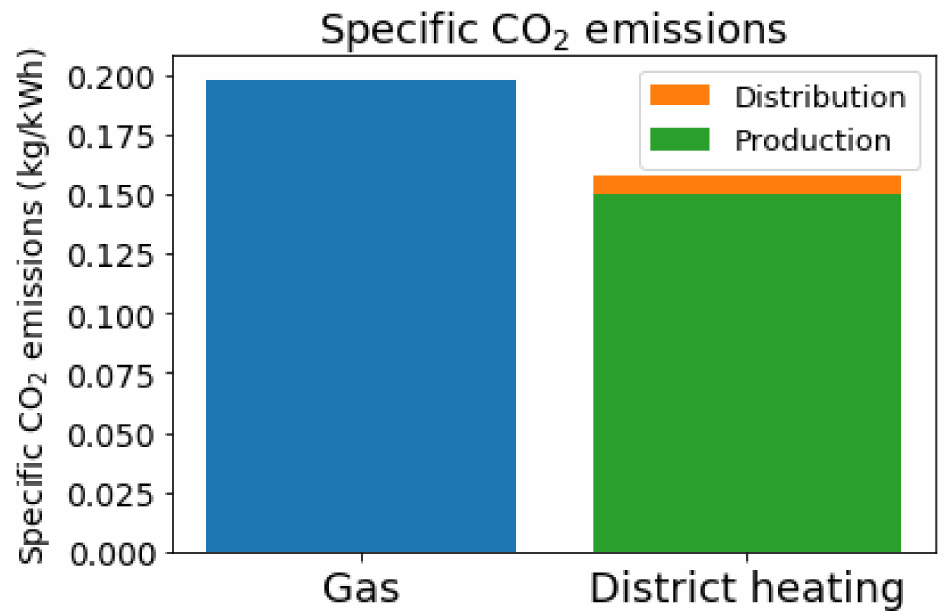
Figure 11. Specific CO 2 emissions with a heating network and decentralized gas